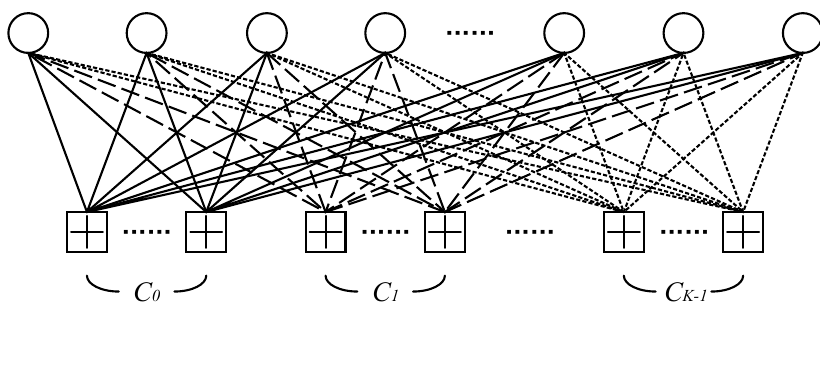
Figure 3. Multi-edge-type LDPC